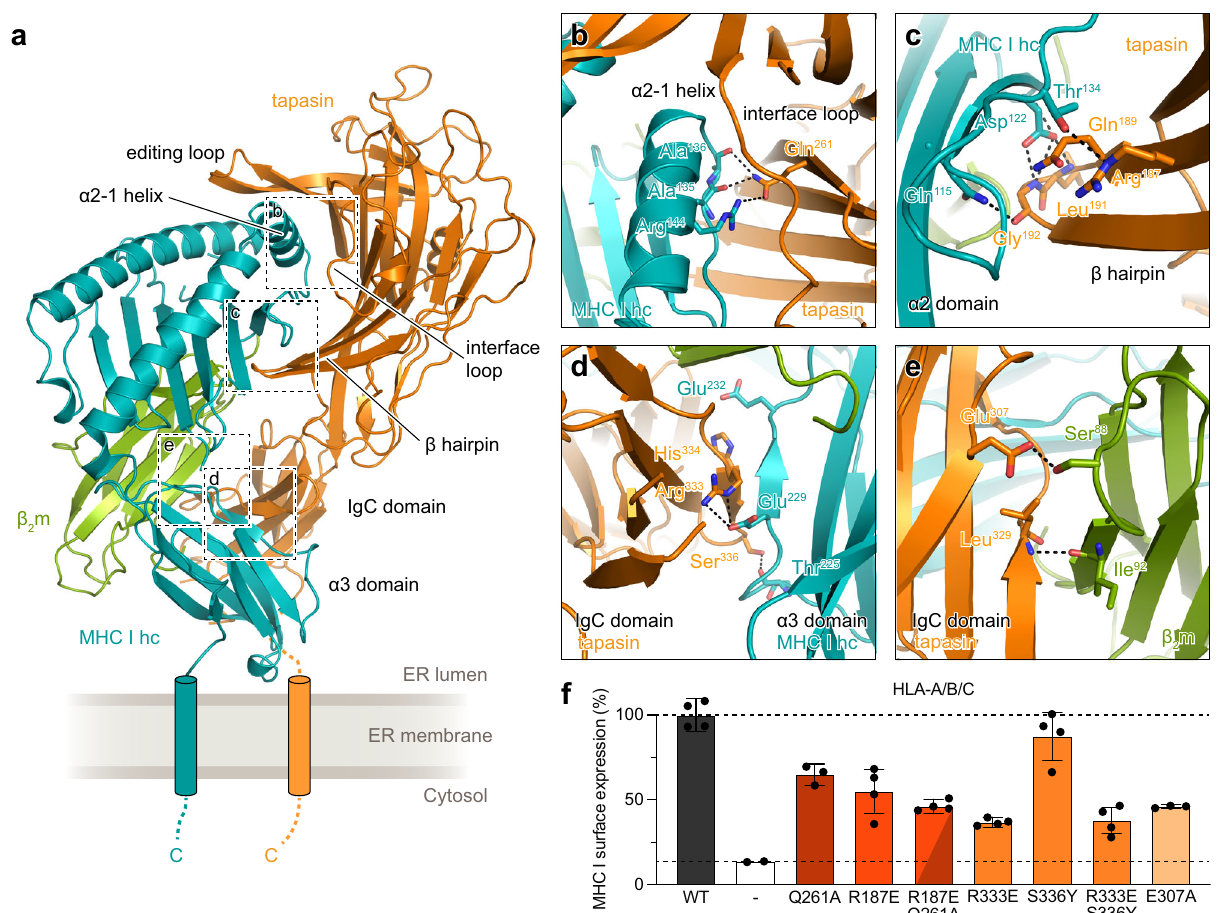
Fig. 4 | Molecular interactions at chaperone-client interfaces affect MHC I surfaceexpression.a Cartoonrepresentationofthechaperonecomplexasshown in Fig. 1c. Thecomponents tapasin, MHCI hcand β 2 m are displayed in orange,teal and green, respectively. Regions magni fi ed in b – e are indicated by dashed boxes. ERp57 is not shown for the sake of clarity. Transmembrane helices and C-terminal regions (C) of MHC I hc and tapasin are indicated schematically. b Zoom-in of the α 2-1helixregionofMHCIandtapasin.Interfaceresiduesforminghydrogenbonds (black dashed lines) are shown as sticks. c Magni fi cation of the interface formed between the β hairpin of tapasin and the α 1/ α 2 domains of MHC I. d Close-up view oftheC-terminaldomainoftapasinandthe α 3domainofMHCI. e Interfaceformed between β 2 mandtheIgCdomainoftapasin. f RestoredMHCIsurfaceexpressionof